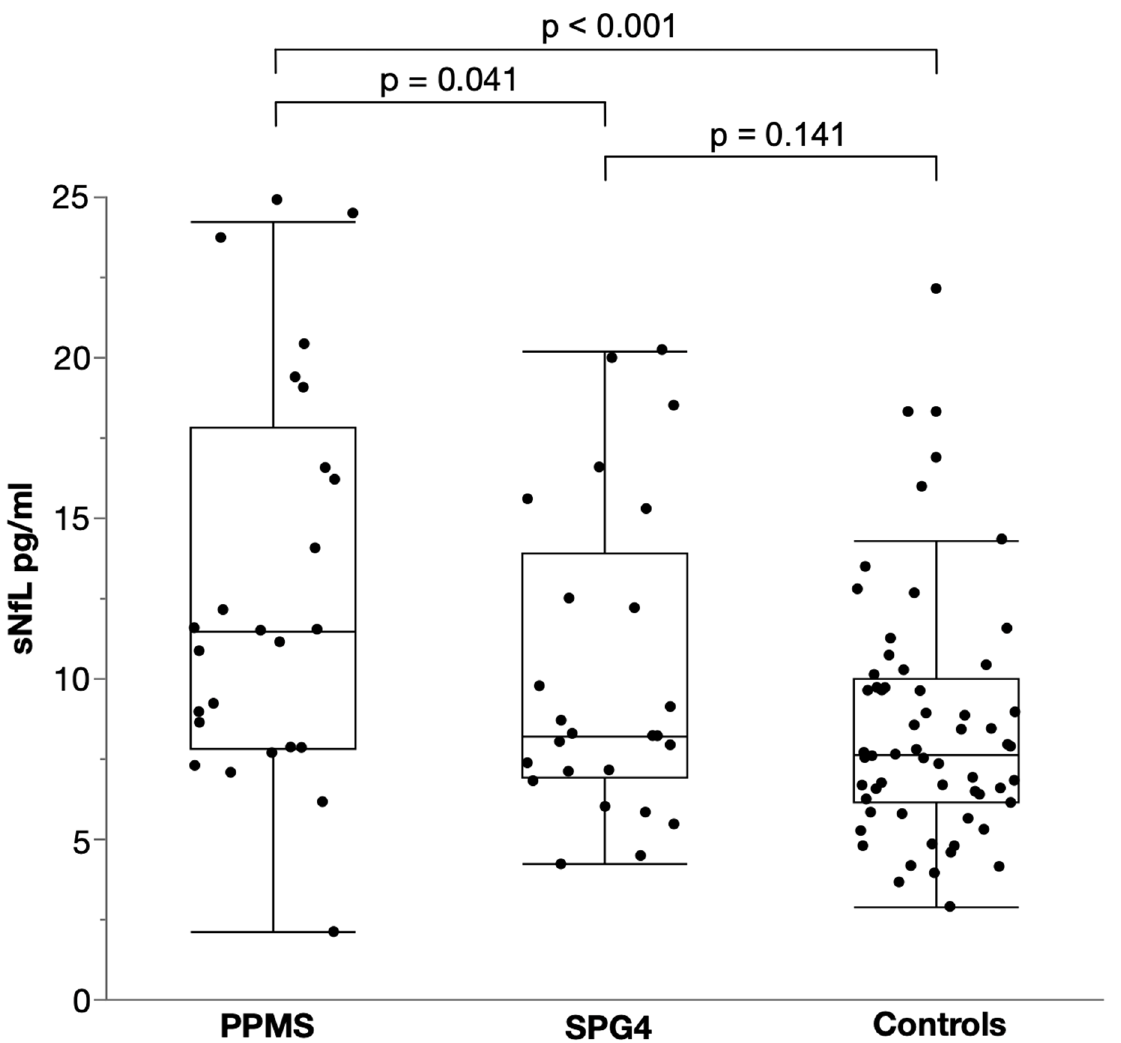
Figure 1. Scatter and box plot of serum NfL levels in PPMS, SPG4 and controls. Horizontal lines represent medians, boxes show interquartile ranges and whiskers extend to the outermost data points within 1.5 interquartile ranges.